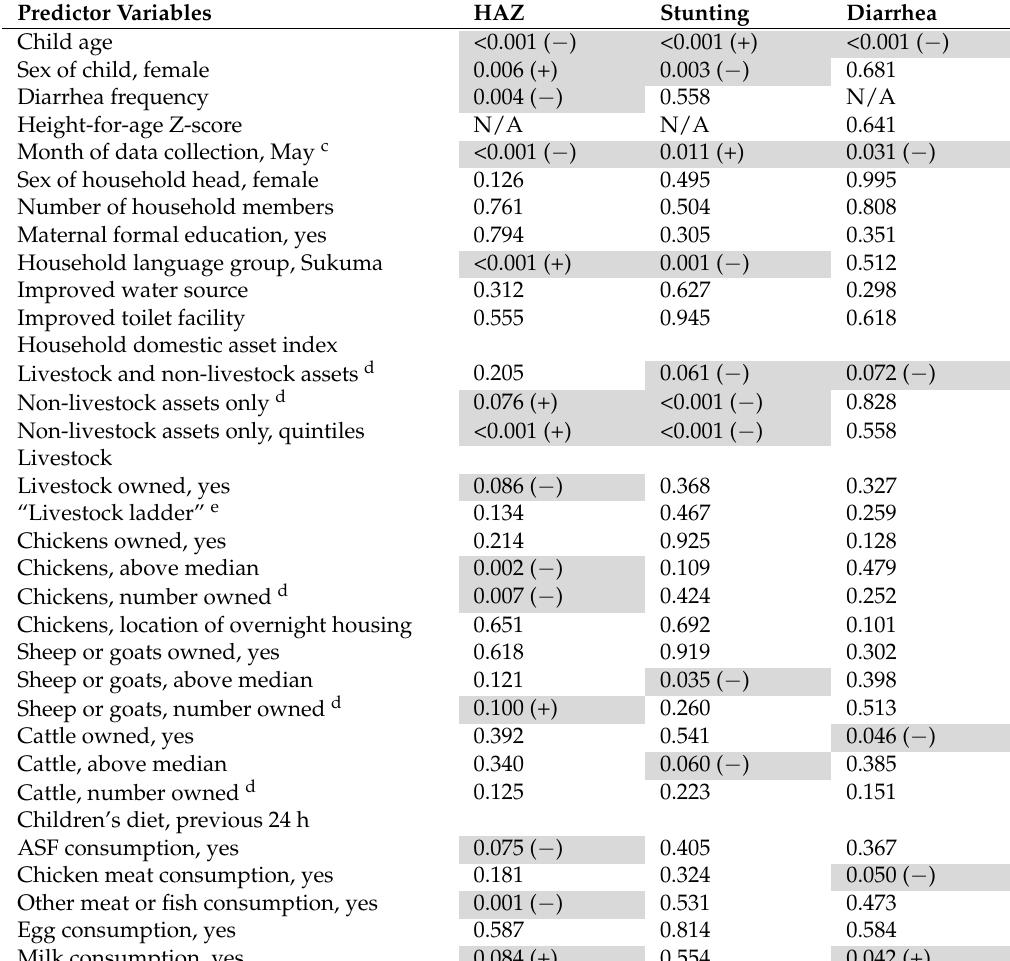
Table A3. Univariable models evaluating the significance of predictor variables for height-for-age Z-scores (HAZ) a , probability of stunting (HAZ < − 2) b and diarrhea frequency b in children, showing p -values and the direction of associations (+/ − ). Grey shading indicates all suggestive associations ( p <